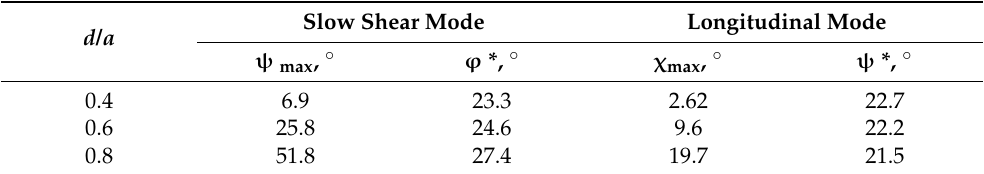
Table 2. Maximum values of the energy walk-off angles of acoustic modes in phononic crystals with various normalized hole